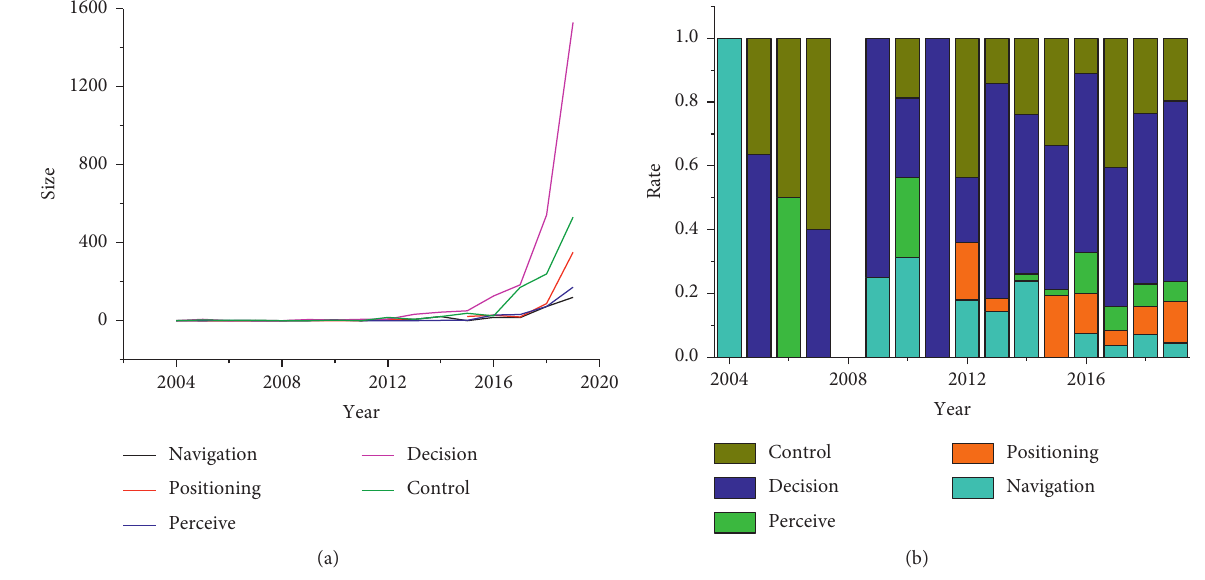
Figure 9: The trend of subdivided topics of “Software” in papers: (a) amount; (b) relative